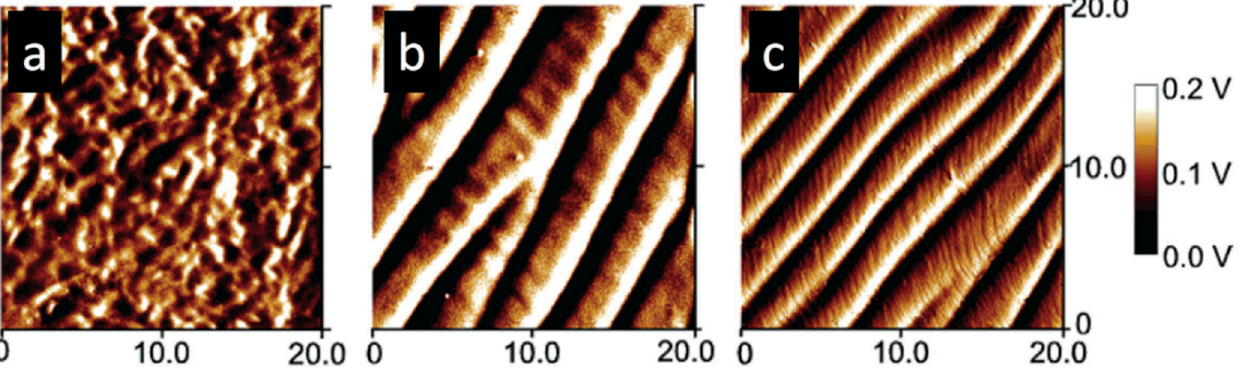
Figure 21. AFM top-view images CNC/HPC sheared films (shear rate 5 mm s − 1 ) from ( a ) isotropic and ( b , c ) liquid-crystalline solutions. Reproduced from [122].